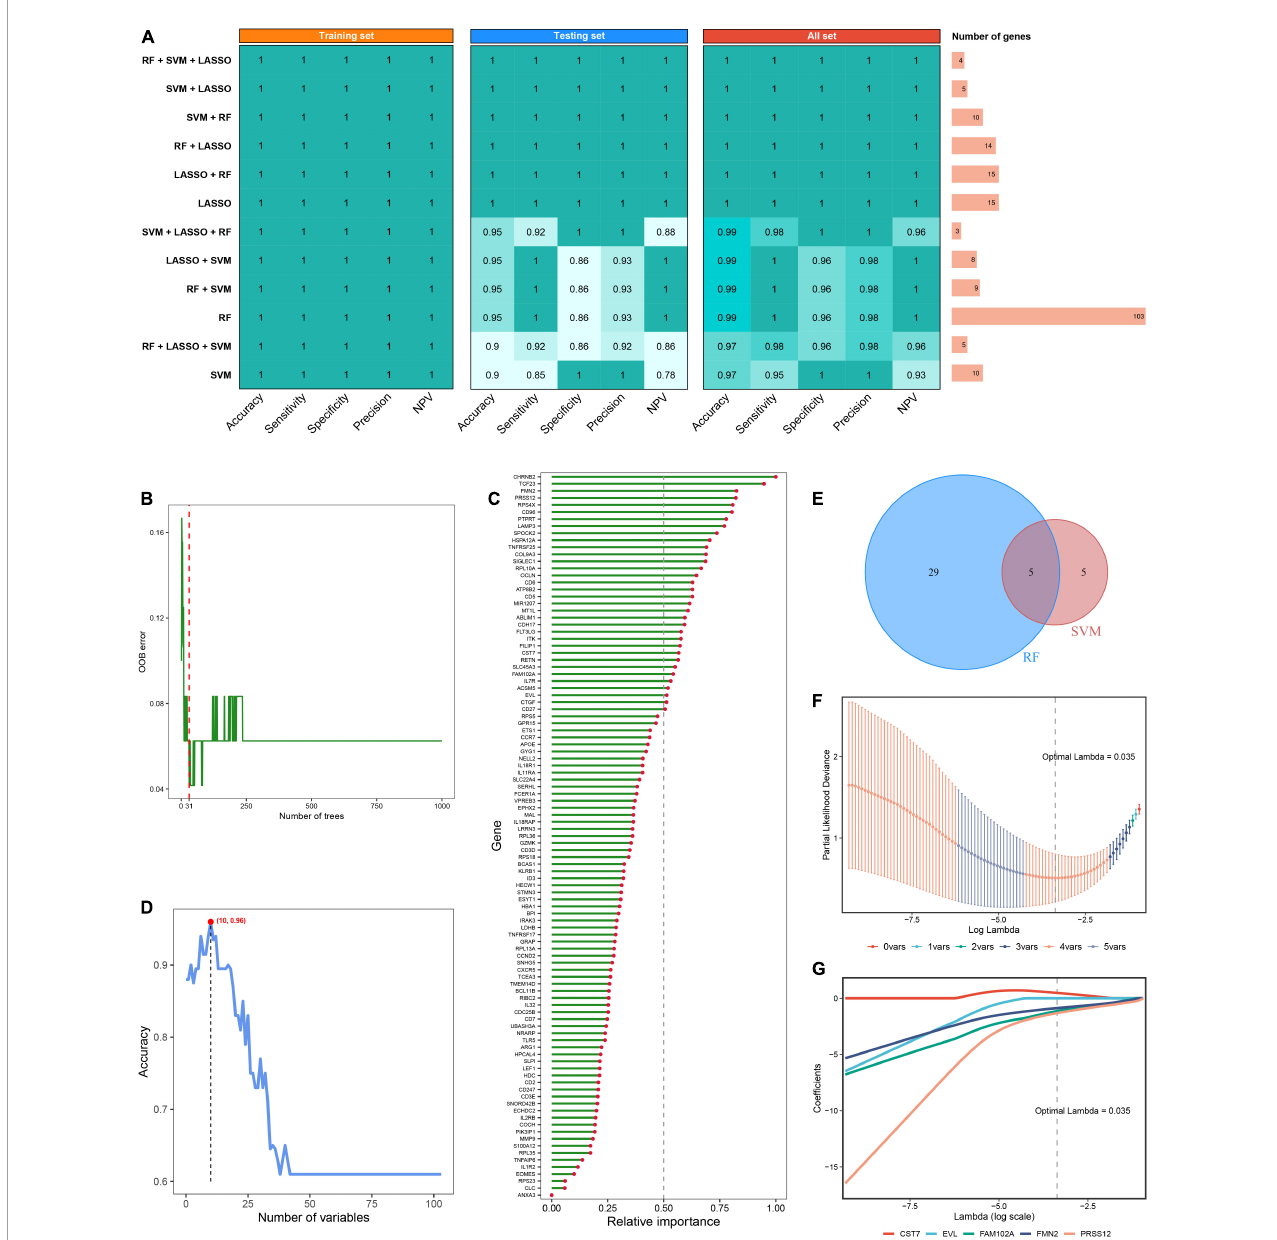
FIGURE3 Machine learning-based integrative approaches for signature generation. (A) Accuracy, sensitivity, specificity, precision and NPV of 12 kinds of dichotomous models in the training set, validation set and all set. The rightmost panel displayed the number of constituent genes for each model. (B) Out of bag (OOB) error rate reached a minimum when the number of trees was equal to 31 in RF. (C) Relative importance of 103 initial input gene variables calculated in RF. Genes with relative importance greater than 0.5 were extracted as important gene variables. (D) Accuracy reached a maximum when the number of variables was equal to 10 in SVM. (E) Venn diagram of the intersection of important gene variables obtained from RF and SVM pre-screening. (F) The optimal lambda was determined when the partial likelihood deviance reached the minimum value in LASSO regression. (G) LASSO coefficient profiles of the candidate genes for MLDGS